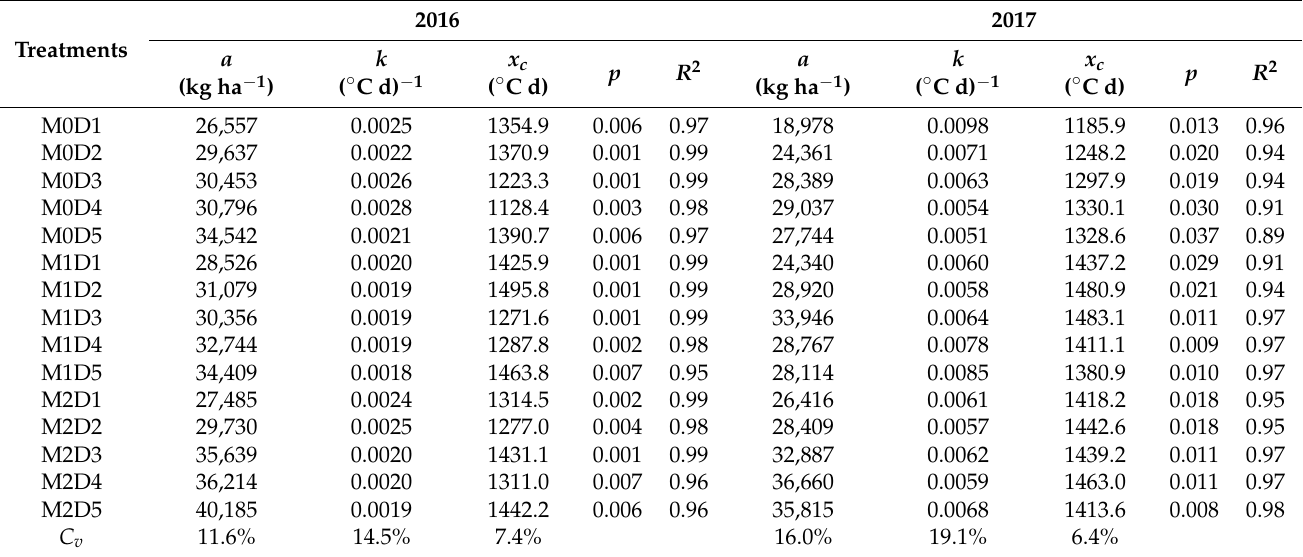
Table 5. Logistic curve parameters ( a , k , and x c ) and statistic test ( p and R 2 ) of the dry matter accumulation of spring maize.